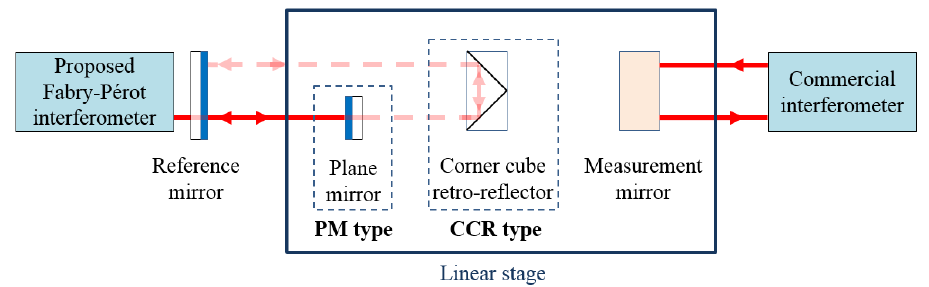
Figure 9. The optical arrangement of the comparison experiment between the commercial and proposed